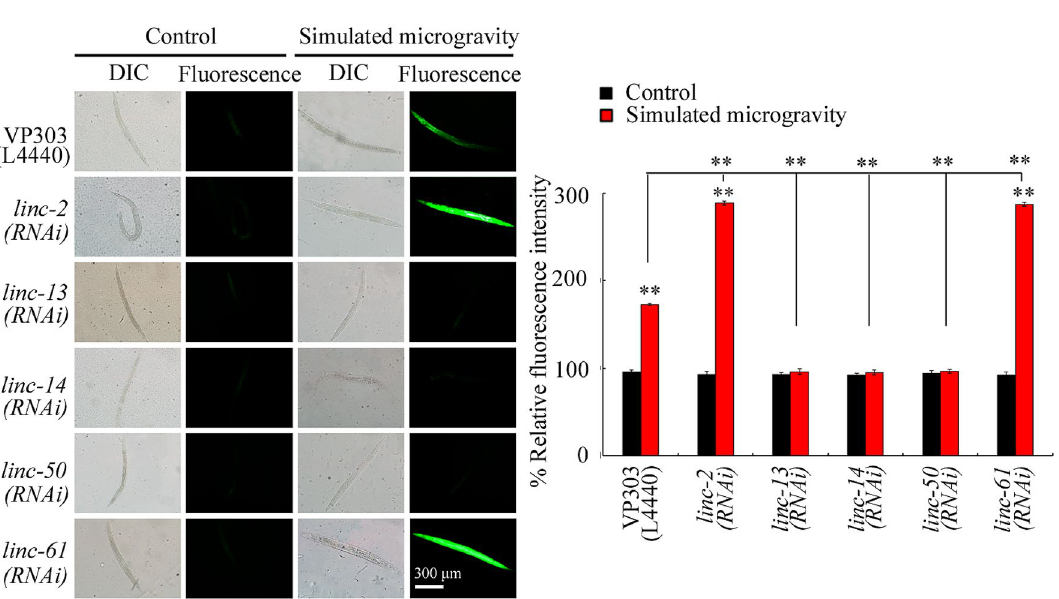
Figure 3. Effect of intestine-specific RNAi knockdown of linc-2 , linc-13 , linc-14 , linc-50 , or linc-61 on ROS production in simulated microgravity treated nematodes. N = 50. L4440, empty vector. Simulated microgravity treatment was performed in RCCS system at 30 rpm for 24 h. Bars represent means ± SD. ** P < 0.01 vs control (if not specially